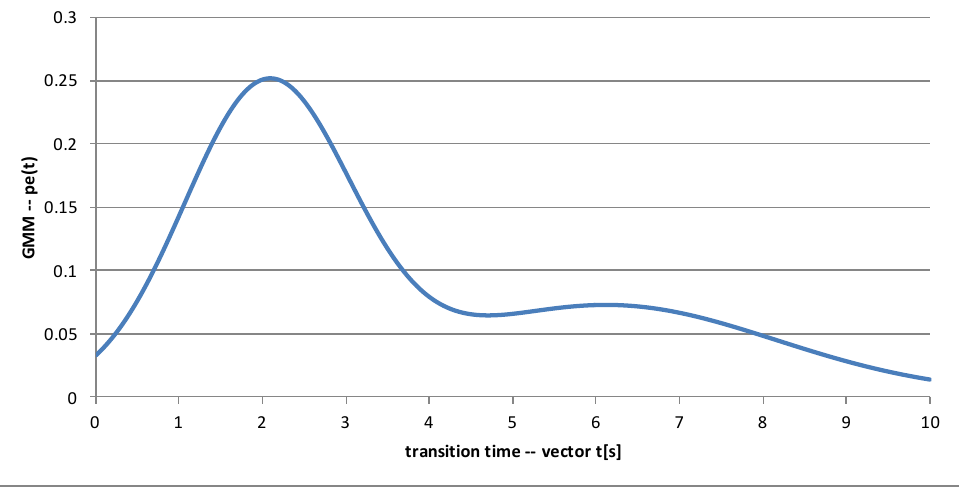
Figure 13. GMM after iteration k = 10 of the EM algorithm.